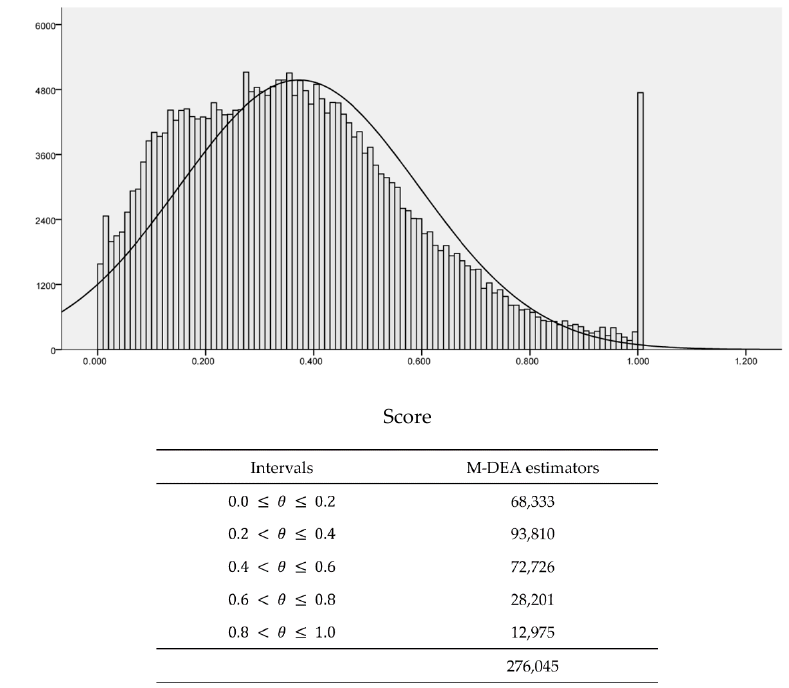
Figure 5. M-DEA estimators ( n = 276,045) and summary by class intervals of scores.